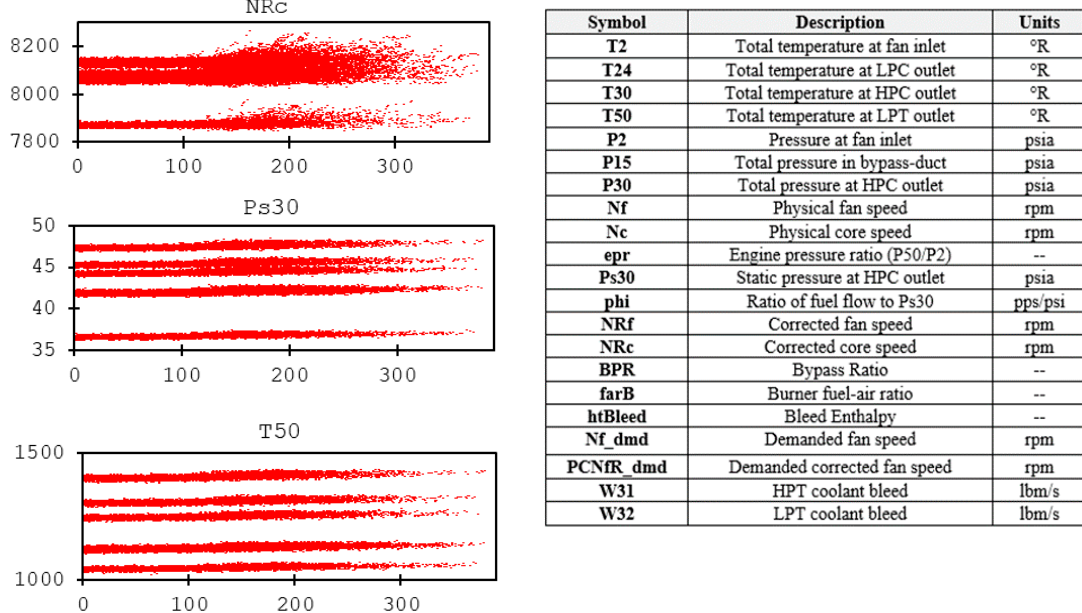
Figure 5. Engine and sensor points ( left ) and engine parts modules connections ( right ) [39].